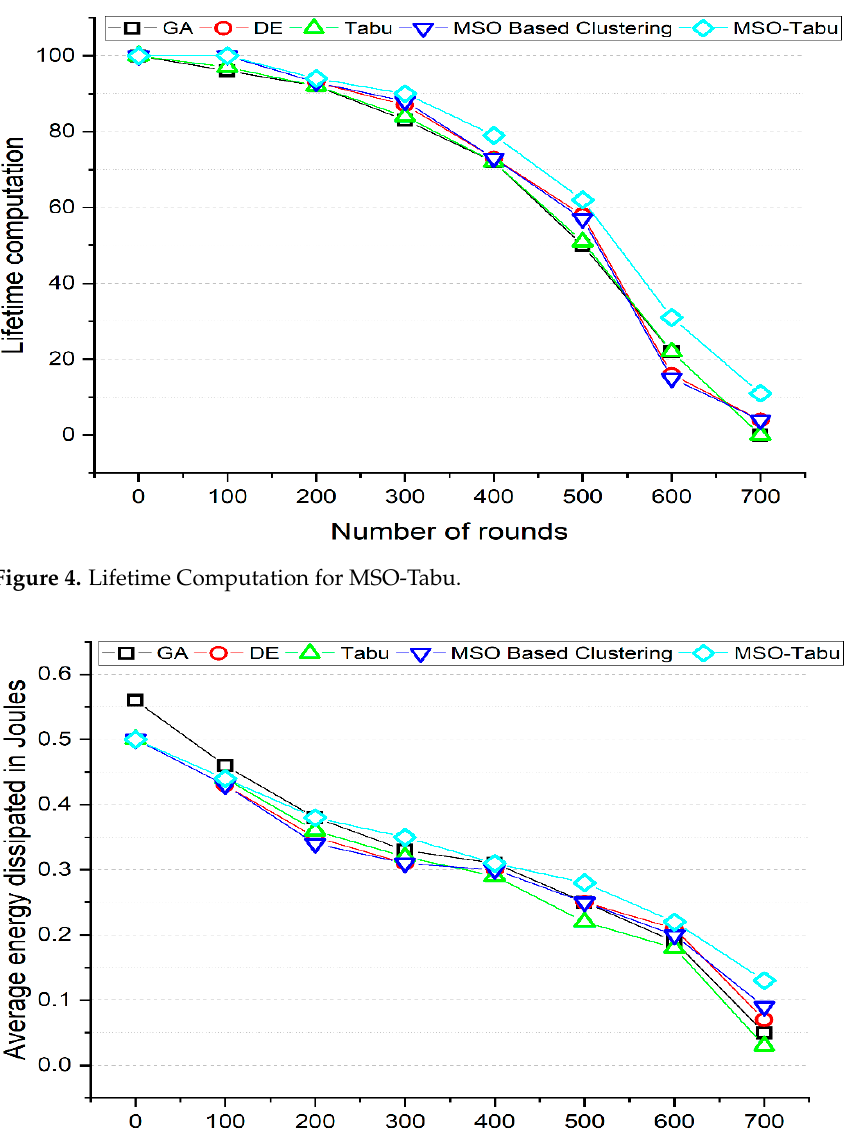
Figure 4. Lifetime Computation for MSO-Tabu.